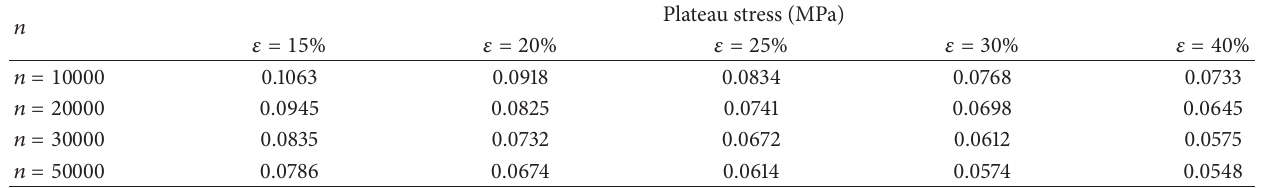
Table 4: Plateau stress of honeycomb paperboard ( 𝑡/𝑙 = 0.0263 ) under various precompression (23 ∘